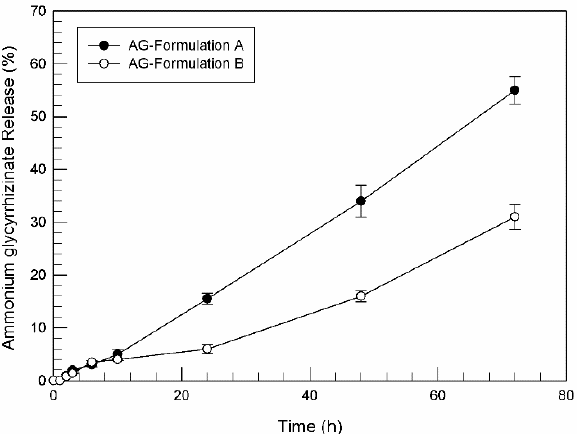
Figure 1. Release profile (%) of ammonium glycyrrhizinate-loaded Formulation A and Formulation B, as a function of time. Experiments were carried out using dynamic diffusion Franz cells and synthetic membrane, and the results were expressed as mean values of three different experiments from three different batches ± standard deviation. If bars are not visible, they are within the symbol.